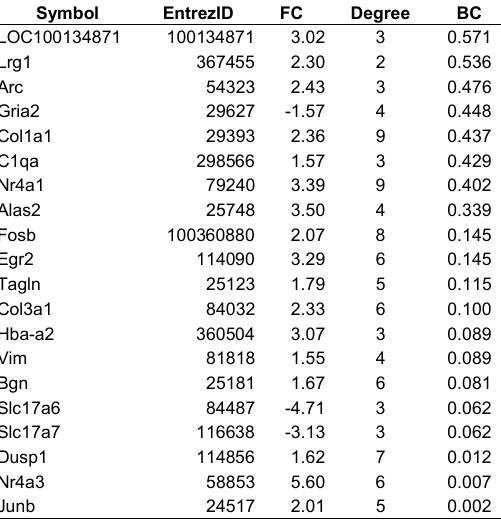
List of top 20 hub genes from PPI network in striatum